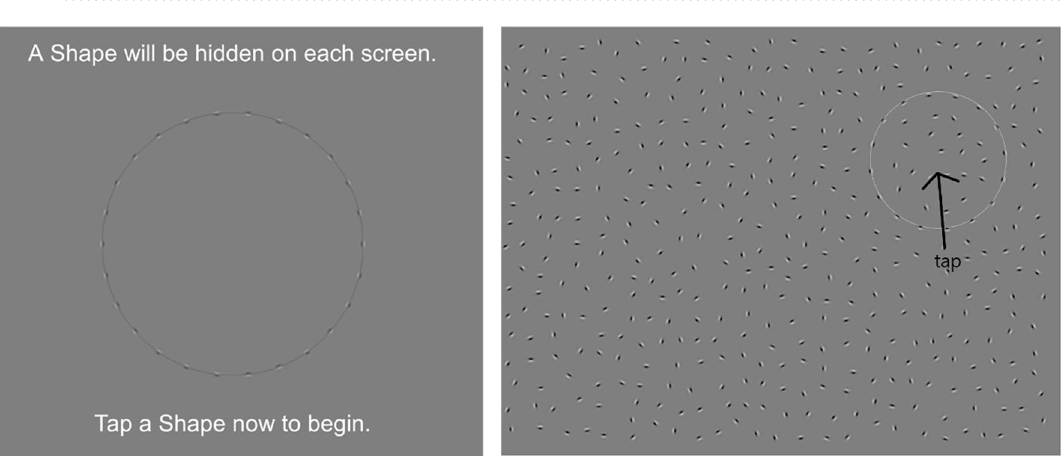
images, that were comparable in reaction times of finding the target. The dependent variable was the reaction time for correct responses to find the target. Contrast sensitivity. This task was based upon low-contrast target detection tasks previously used in studies of visual perceptual learning 43 . Participants were presented with Gabors (mathematically a sine-wave windowed by a Gaussian) shown one at a time at random positions on the screen (Fig. 3). Gabors were presented at 12 cycles per degree (with a standard deviation of 0.75 degrees for the Gaussian window and thus an extent of ~ 2.5° on screen—based on a typical viewing distance of 18 ″ ) for up to 4 s each, with a 50 ms ramp to mask the onset. A linear color look-up table was used to ensure proper presentation of the Gabors’ luminance profile and Michel- son contrast was calculated. While we cannot guarantee that this leads to perfect rendering of the luminance profile of the Gabors on all devices, these settings are reliable on most modern tablets and smartphones and to whatever extent that there was any distortion of the luminance profile for some participants this would be